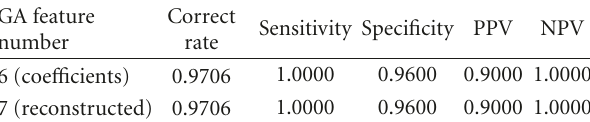
Figure 7: Selected approximation coe ffi cients for test samples of prostate cancer dataset. Table 1: Performance of selected GA features. This table shows the performance for prostate cancer dataset. The two experiments are based on 6 selected GA features from approximation coe ffi cients at 2nd level and 7 selected GA features from reconstructed approximation at 2nd level. PPV stands for positive predictive value; NPV stands for negative predictive value.